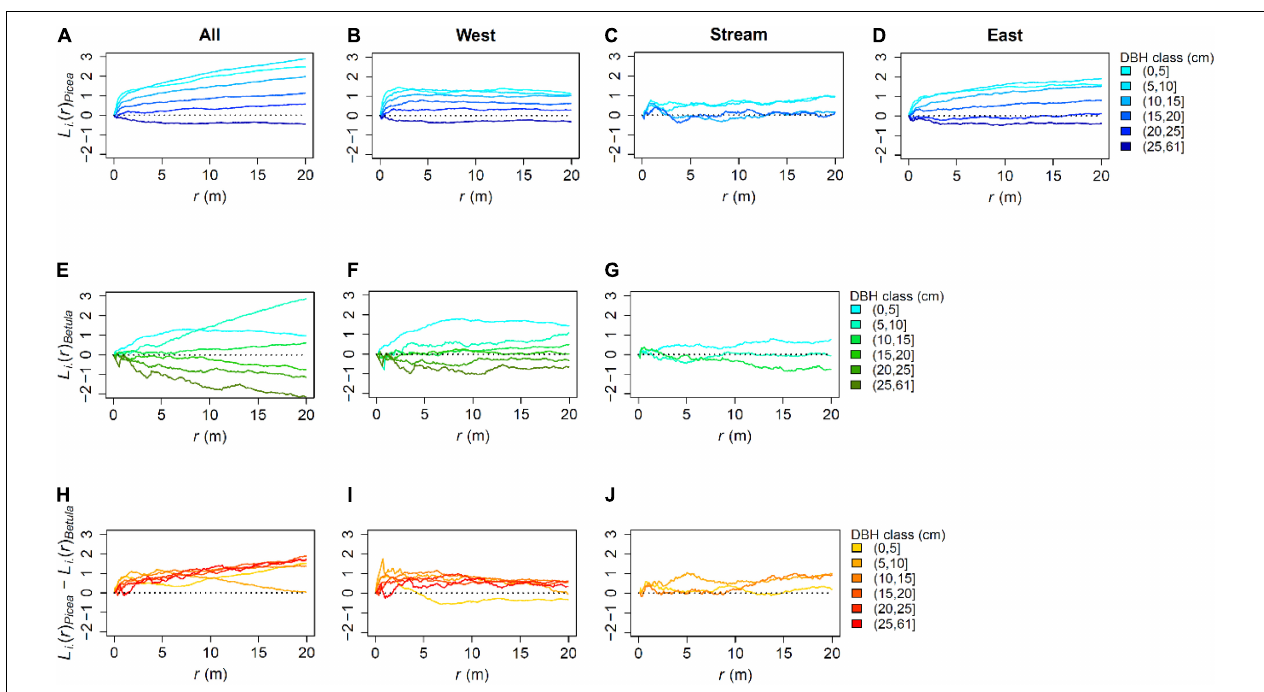
FIGURE 8 | “i-to-any” L-functions for live P. abies , B. pubescens and the function values of P. abies substracted from those for B. pubescens for the whole study plot and the subplots: (A) All Picea , (B) Picea in the West, (C) Picea in the Stream area, (D) Picea in the East, (E) All Betula , (F) Betula in the West, (G) Betula in the Stream area, (H) combined function for all trees, (I) combined function for trees in the West, and (J) combined function for trees in the Stream area. The function values are calculated from the number of trees (of any kind) within a given distance r from trees of the focal type i . The focal types are chosen by species and diameter at breast height (DBH). Thus, the functions can be interpreted as summaries of local tree densities and their scale-dependence around different types of trees. For the combined functions (H–J) , values higher than 0 indicate that P. abies grows under higher local densities than B. pubescens .